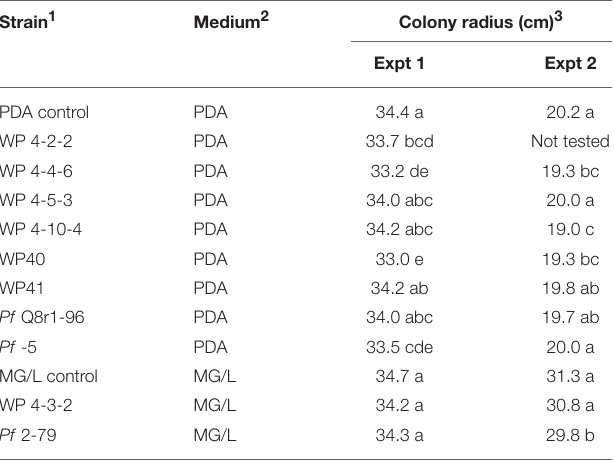
TABLE 4 | Evidence for production of volatile inhibitory compounds in bacterial endophytes. Strain